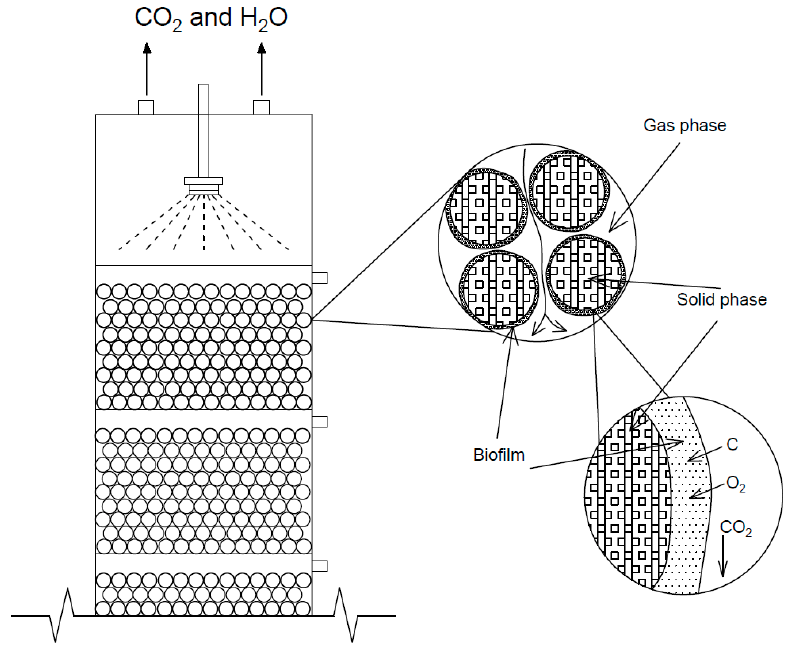
Figure 3. Schematic diagram of the acetone biofiltration process on bioballs.